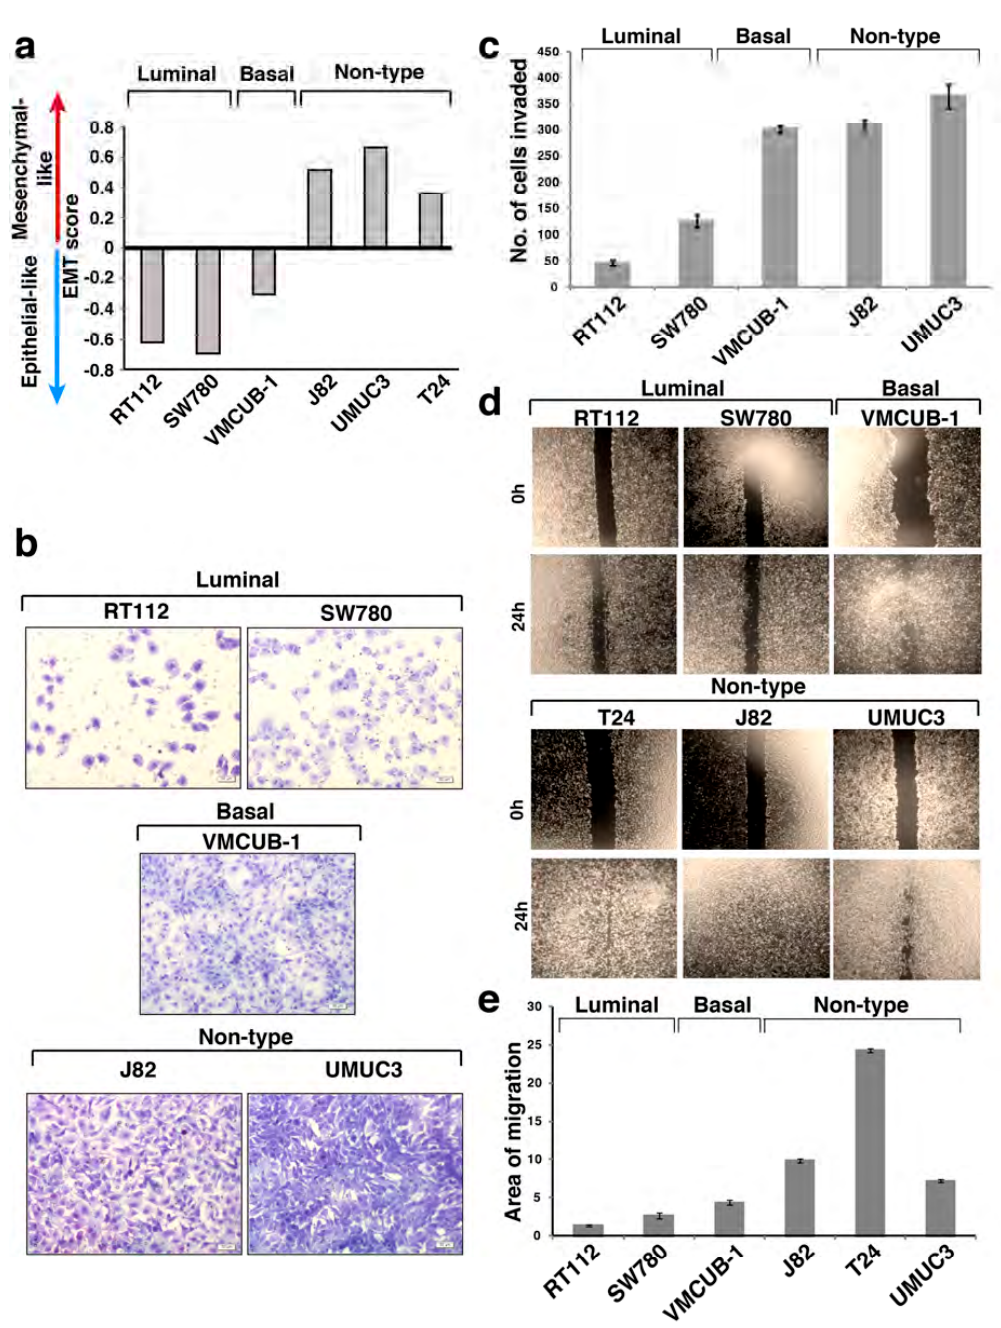
Figure 1. ( a ) Epithelial-mesenchymal transition score of the molecular subtypes of bladder carcinoma cell lines. ( b ) Invasion assay. Cells which invaded through the Matrigel were stained using methylene blue and imaged at 10× magnification. ( c ) Quantitative analysis of the number of cells which have invaded in each molecular subtype. ( d ) Scratch wound assay. Migration rate of the molecular subtypes of bladder carcinoma cell lines (magnification: 10×). ( e ) Quantitative analysis of scratch wound assay of the molecular subtype of bladder carcinoma.